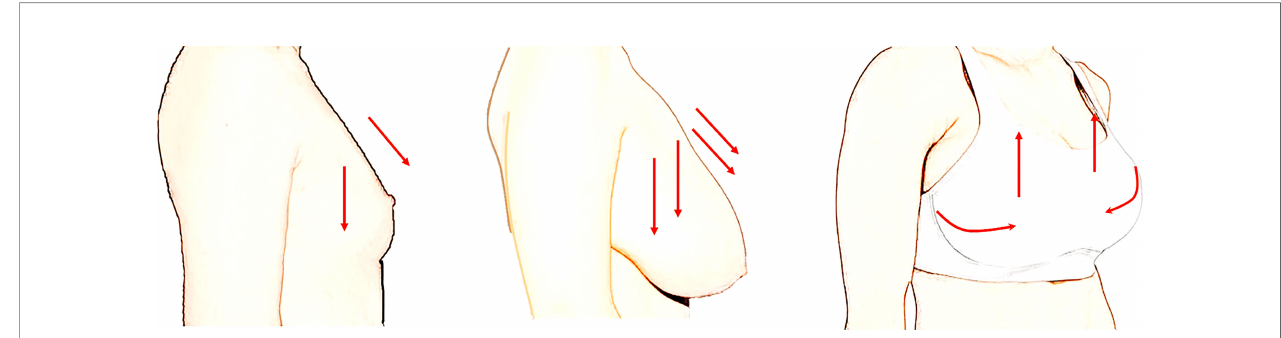
FIGURE 2 | Schematic drawing of skin tension induced by breast and the effect of sports bras. Breast size was considered to be an important factor inducing high skin strain on anterior-chest. Wearing sports bras after surgery can reduce ongoing tension and thus consistently improve keloid management and prevent keloid recurrence.